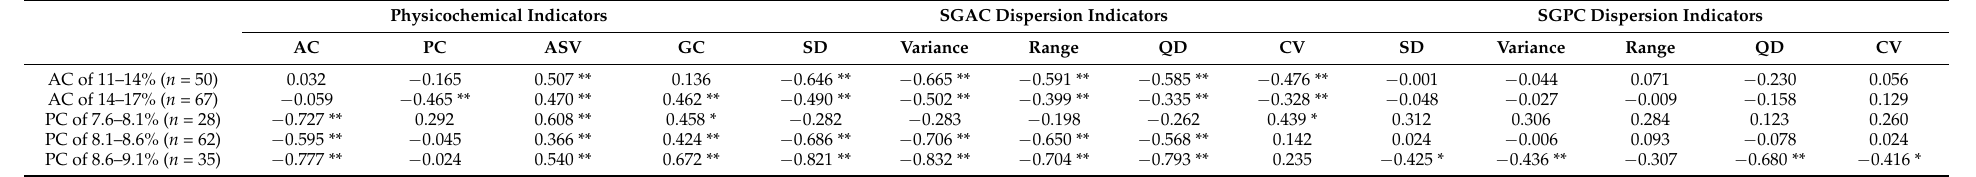
Table 4. Correlation coefficients between physicochemical indicators, variation indicators (SD, variance, range, QD, and CV) in SGAC and SGPC, and taste value of hybrid indica rice with similar